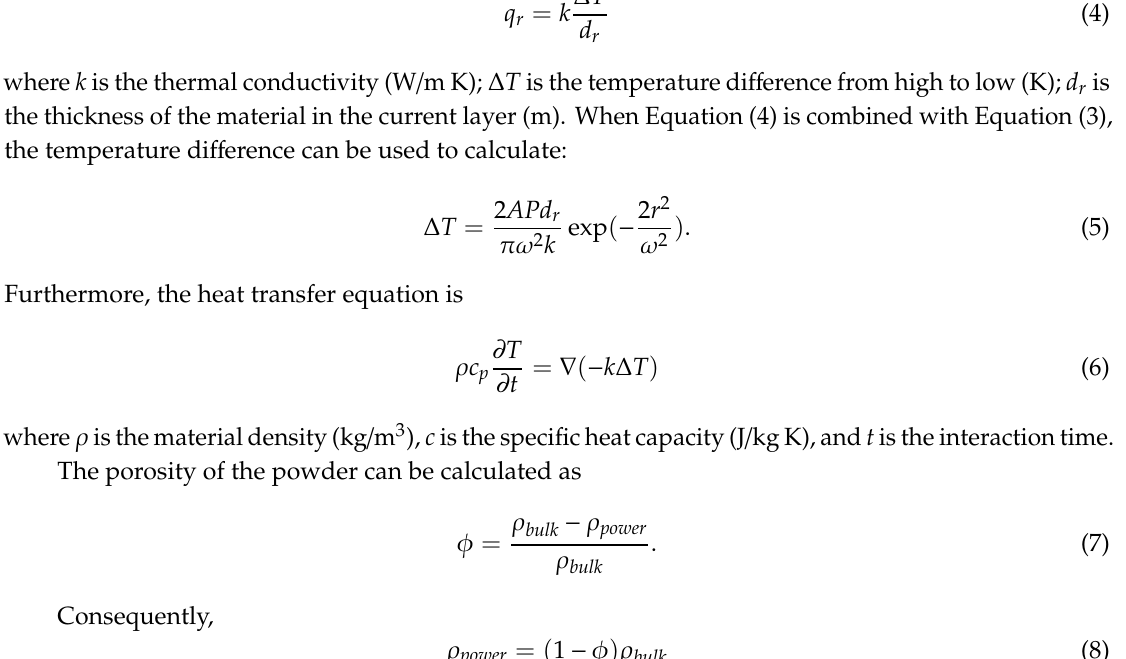
Figure 1. Heat source and scanning path. ( a ) Gaussian heat source; ( b ) layer-by-layer scanning path.